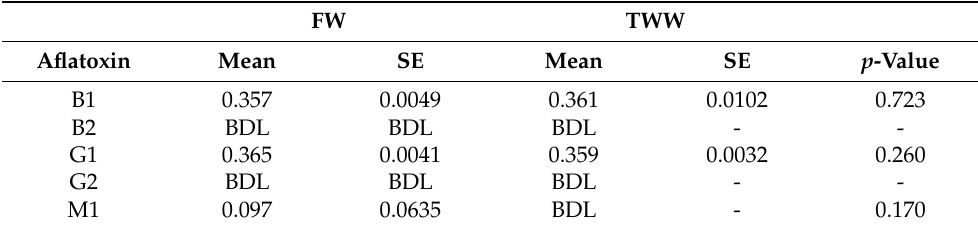
Table 6. Effect of water source on mycotoxin in